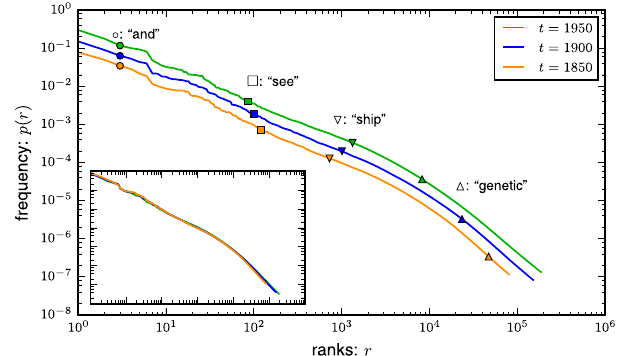
FIG. 1. The English vocabulary in different years. Rank- frequency distribution p ð r Þ of individual years t for t ¼ 1850 , 1900, and 1950 of the Google-ngram database [10], multiplied by a factorof1,2,and4,respectively,for bettervisual comparison.The insetshowstheoriginaluntransformeddata(sameaxis),highlighting that the rank-frequency distributions are almost indistinguishable. Individual words (e.g., “ and, ” “ see, ” “ ship, ” and “ genetic ” ) show changes in rank and frequency (symbols), where words with larger ranks (i.e., smaller frequencies) show larger